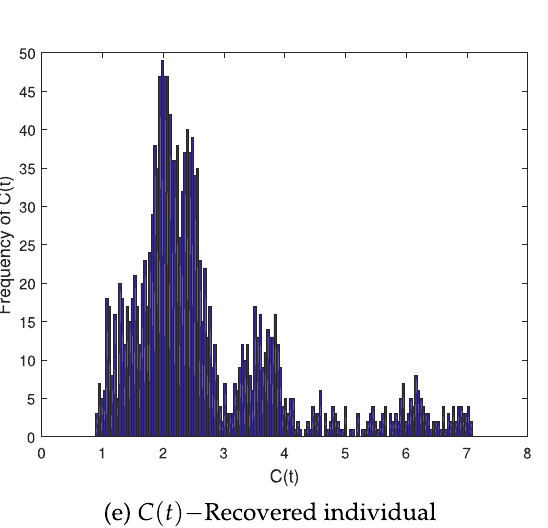
Figure 4. The probability distribution histogram of ( H ( t ), V ( t ), U ( t ), A ( t ), C ( t )) for the stochastic model